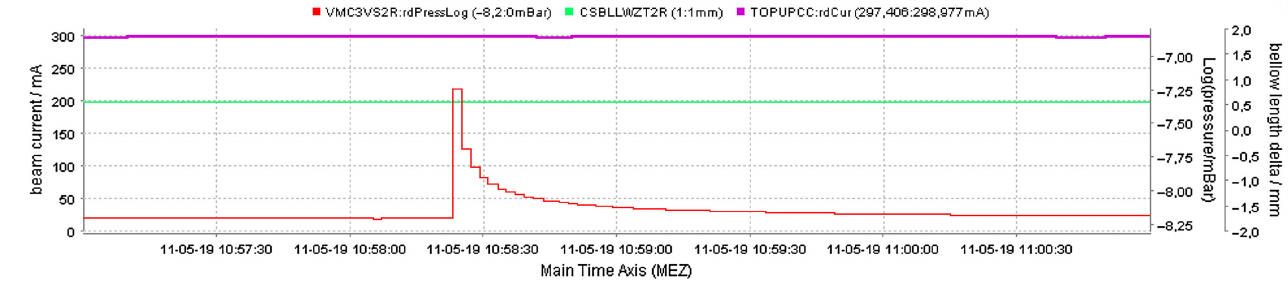
FIG. 15. Singular spike of roughly 1 pressure magnitude (red) as an example of events occasionally (few per month) observed both with the setups of (here) CSB1, CSB2 and also in the replacement straight (used after the dismantling of CSB1 and before installation of CSB2). There is no clear event trigger like a bellow movement (green), temperature (light blue), or fill pattern change (e.g., initiated by a topup injection — gray) observable.